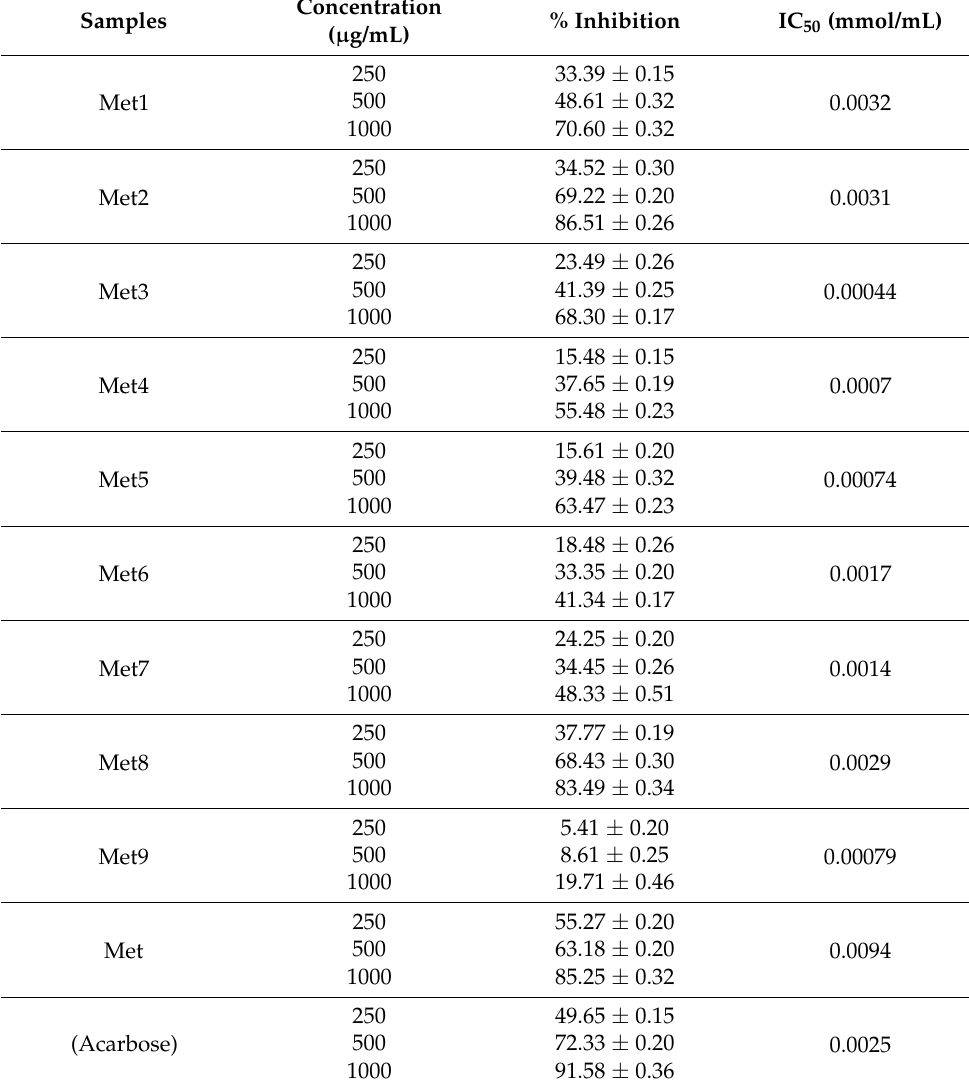
Table 7. α -Amylase activity of